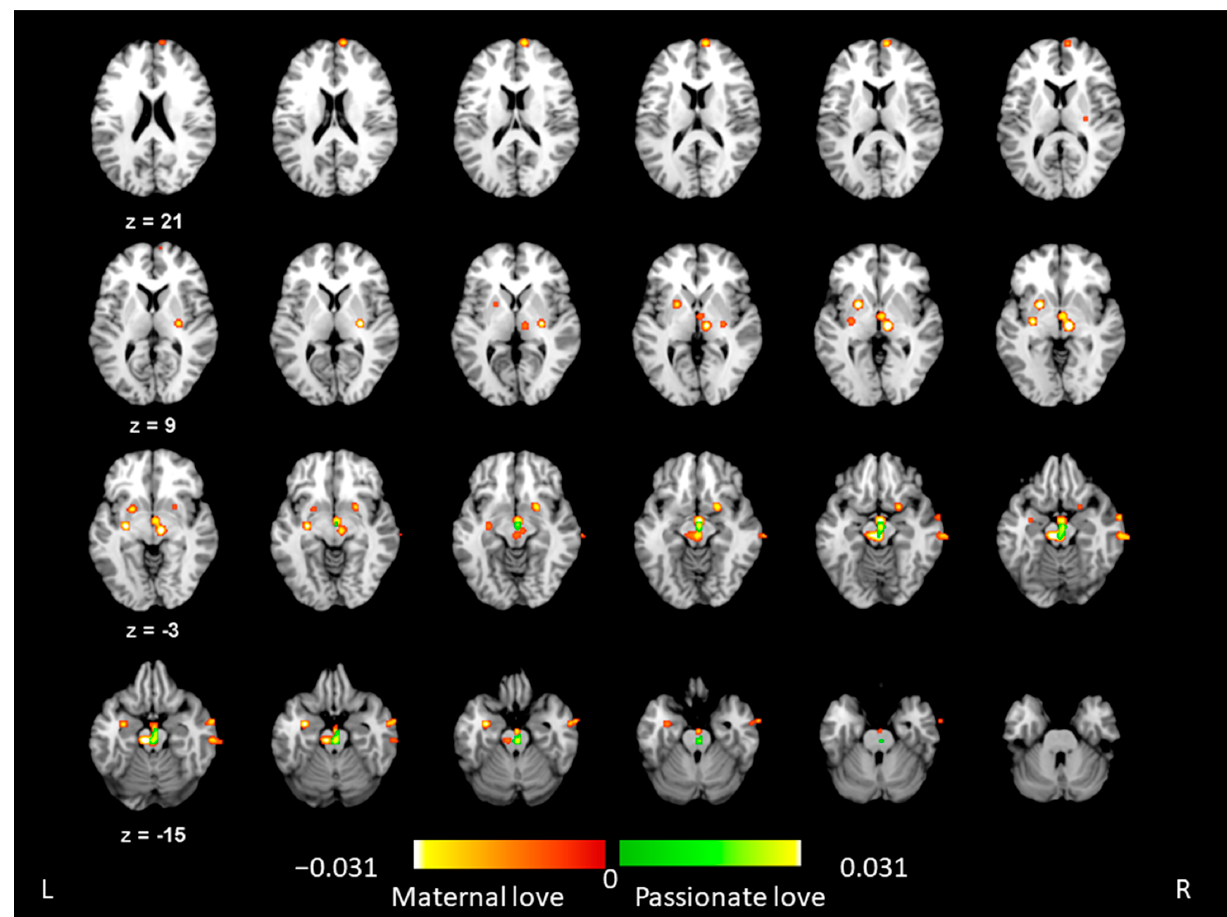
Figure 2. Activation likelihood clusters (FDR pN < 0.01 level) show meta-analytic activations in maternal love (red) or passionate love (green). In maternal love, the activated clusters were centered at the left ventral tegmental area, right thalamus, left substantia nigra, bilateral putamen, right medial prefrontal gyrus, right superior temporal gyrus, right middle temporal gyrus, and left amygdala. A cluster was activated in the meta-analysis of passionate love, centered at the left ventral tegmental area and extending to the right ventral tegmental